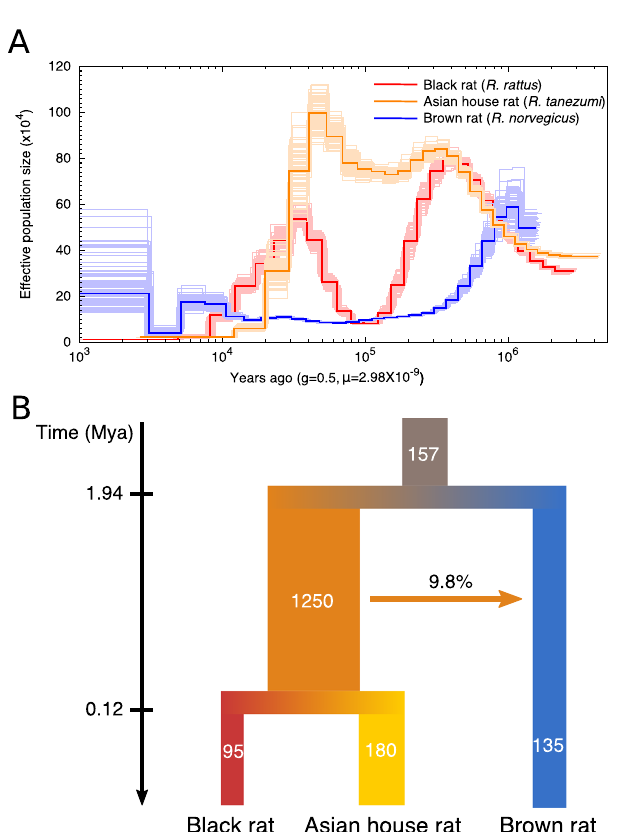
Fig. 1 The demographic history of the black rat and its closely related species. A Population dynamics of the black rat ( R. rattus ), Asian house rat ( R. tanezumi ) and brown rat ( R. norvegicus ) estimated by PSMC, with 100 bootstrap replicates. B Demographic modelling of the divergence and migration among the black rat, Asian house rat and brown rat estimated by G-PhoCS. The values represent the average estimates of effective population sizes (in thousands), population divergence times (Mya) and the total migration rate through time. The 95% HPD range of all estimates are listed in Supplementary Data